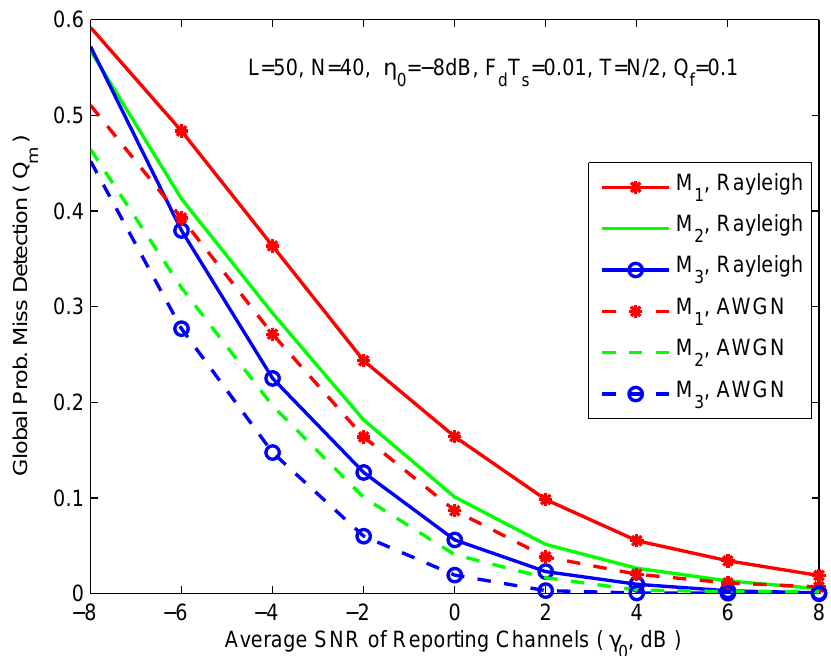
Figure 8. The global probability of misdetection as a function of average SNR of reporting channels.